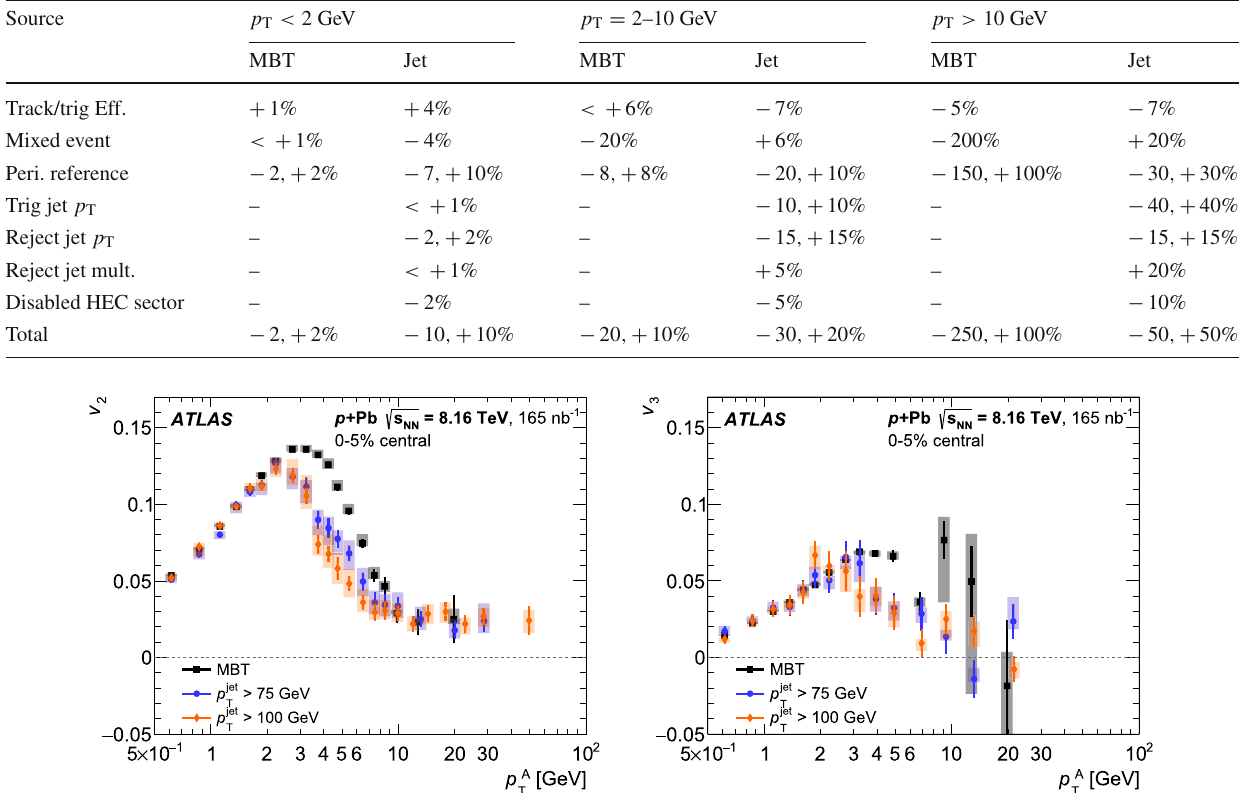
Table 2 Systematic uncertainty summary for anisotropy coefficients v 3 . The values are approximate, as they represent the average variation in each p T range, and are reported relative to v 3 . Negative and positive